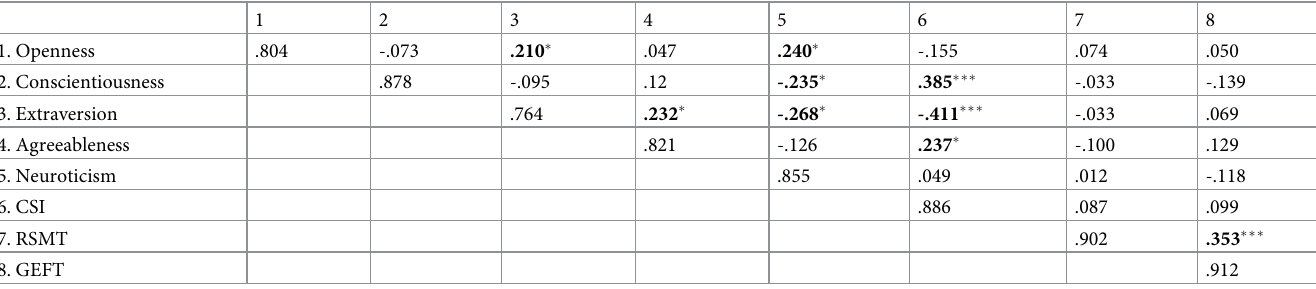
Table 5. Correlation